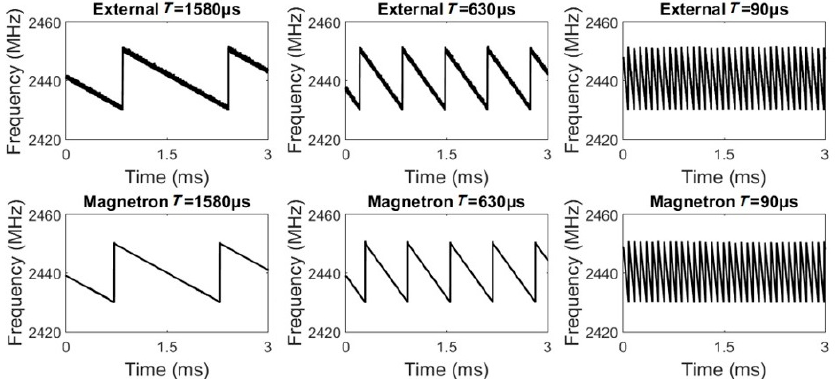
Figure 4. The Freq. vs. Time comparison figure of signal source and magnetron with different sweep rate.